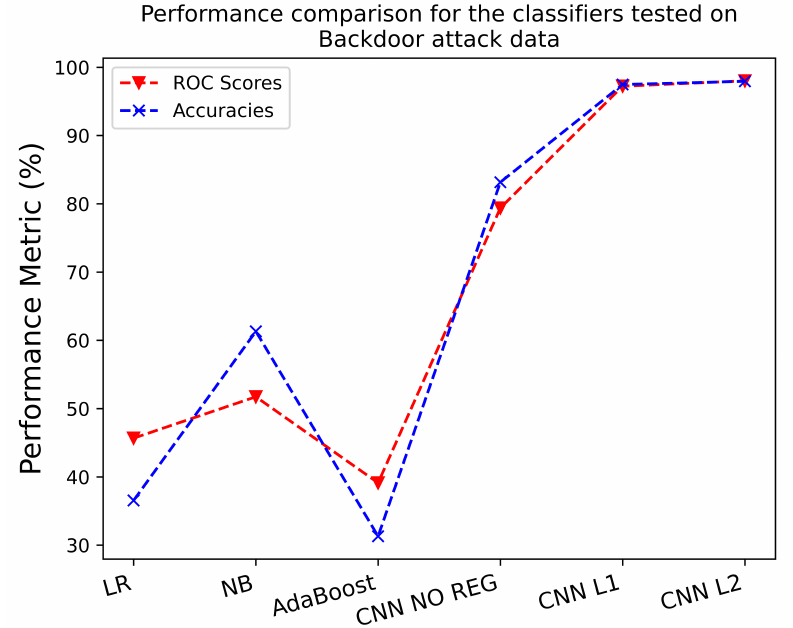
Figure 4. Performance metrics comparison for Scenario A.